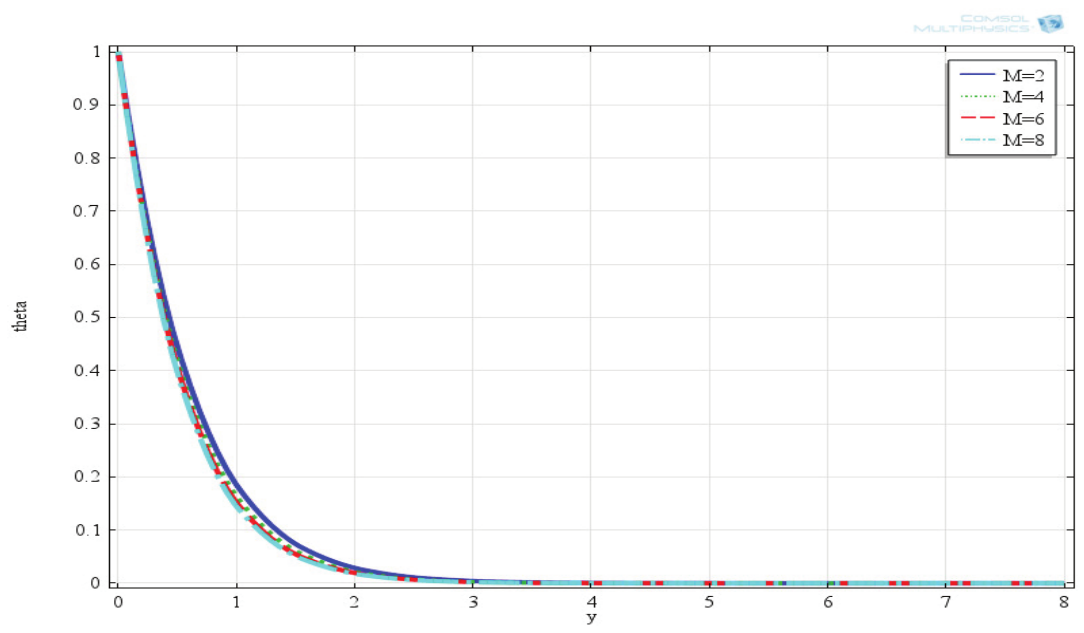
Figure 6: Steady state temperature profiles for different values of M at